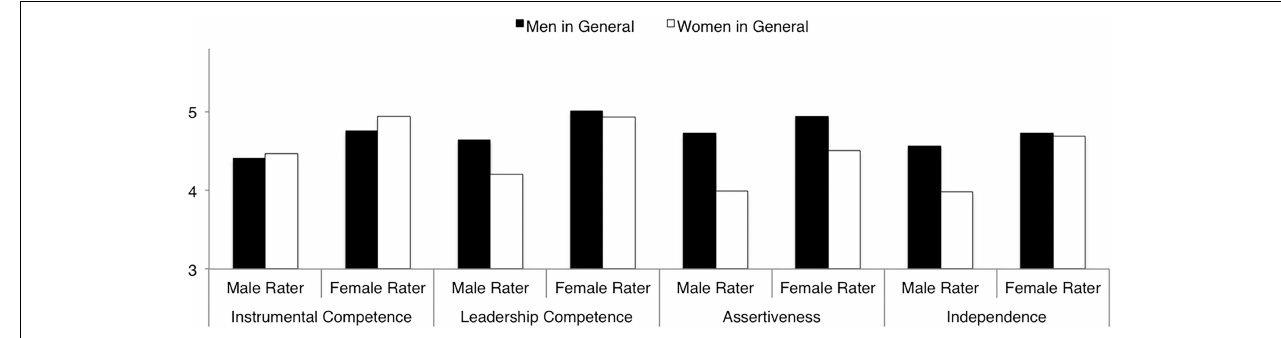
FIGURE 1 | Ratings of agency dimensions (instrumental competence, leadership competence, assertiveness, independence) of men in general and women in general by male and female raters. TABLE 5 | 2 × 4 Agency ANOVA and 2 × 3 Communality ANOVA for self-ratings. 2 × 4 Agency ANOVA 2 × 3 Communality ANOVA